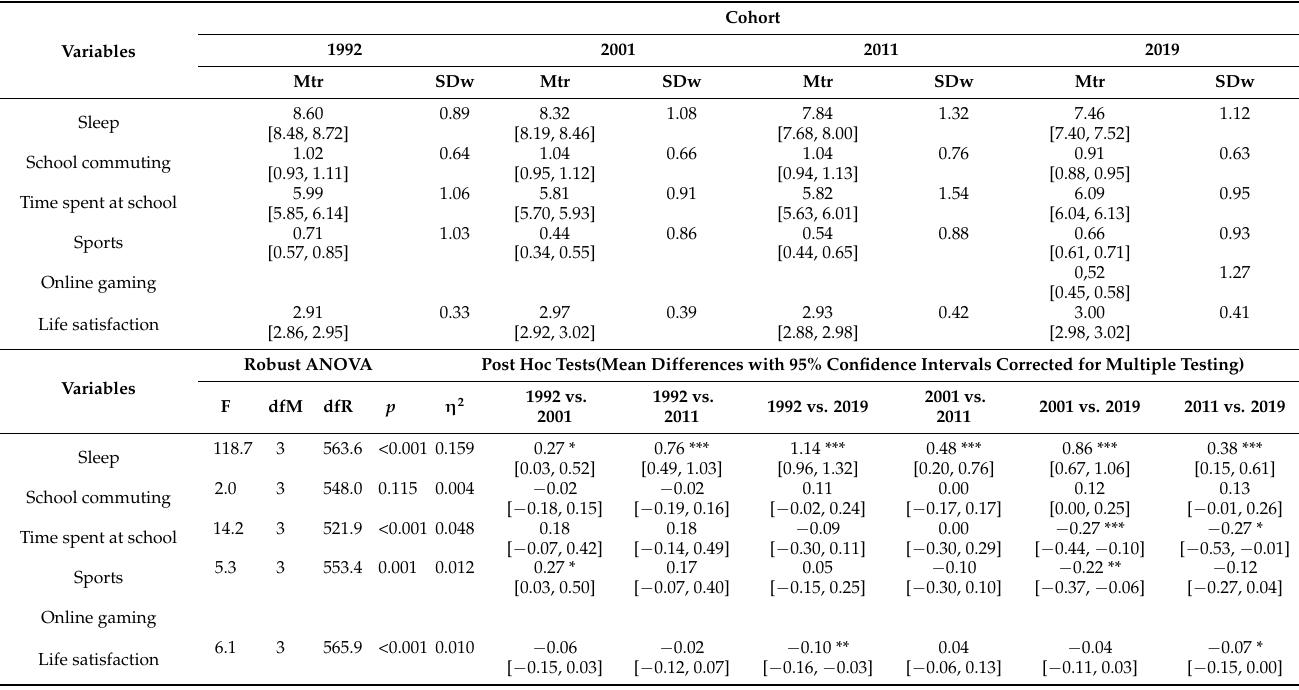
Table 2. Comparison of cohorts using robust ANOVA and post hoc